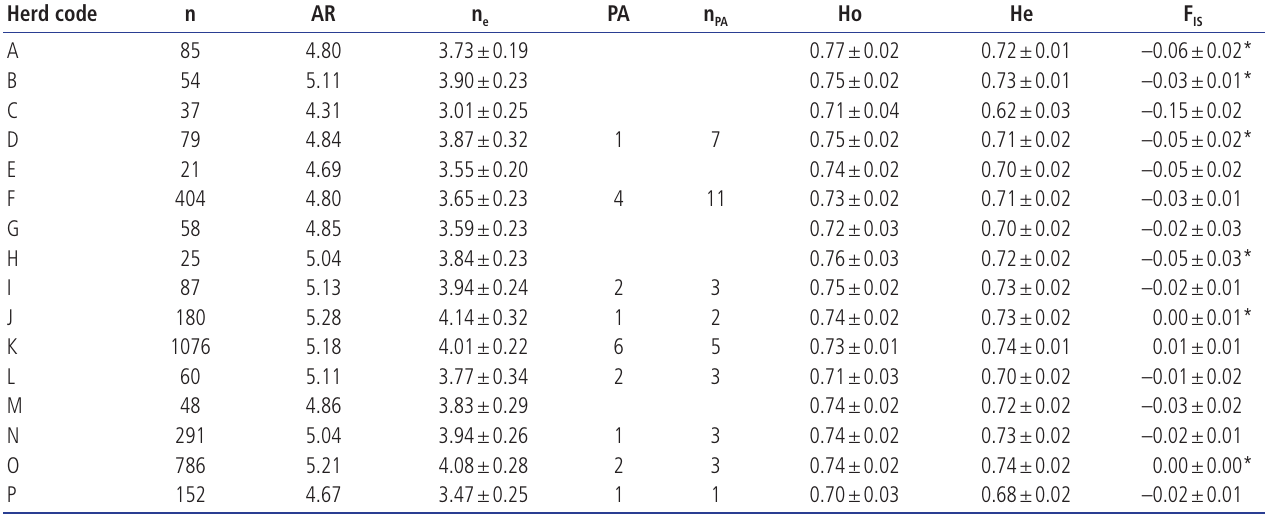
Table 1. Statistical analysis of 16 Limousin cattle herds Herd code